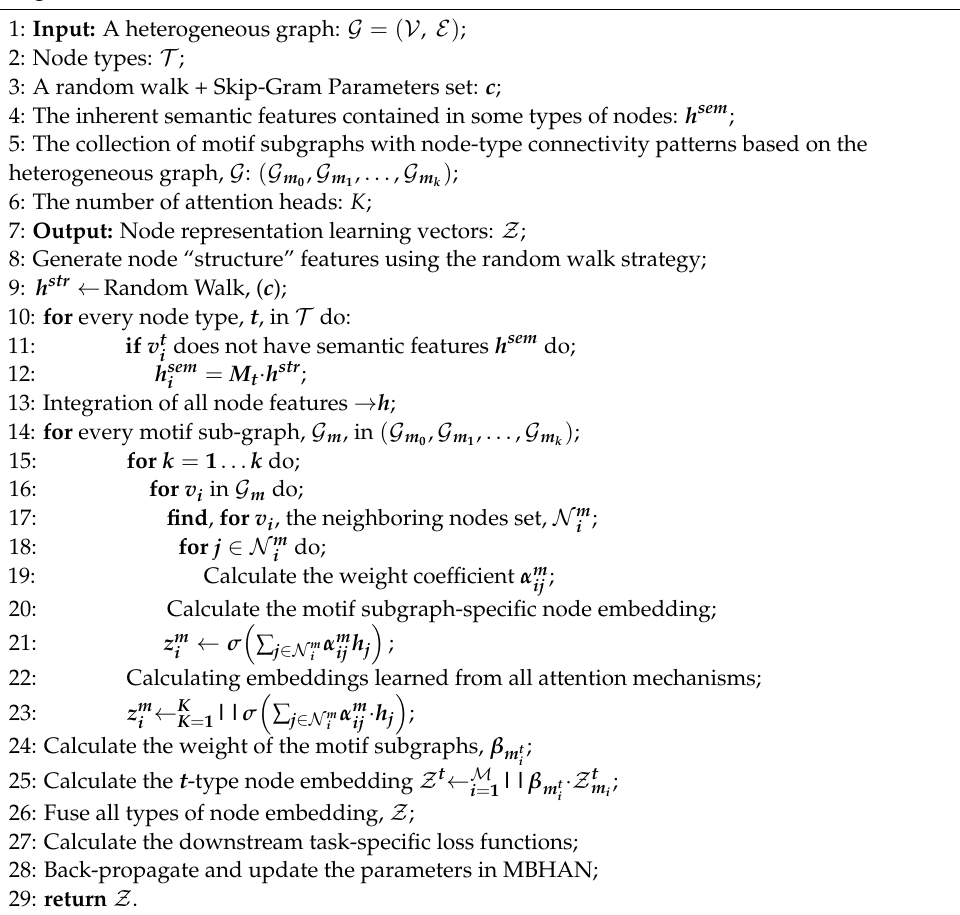
Algorithm 1 The Overall MBHAN